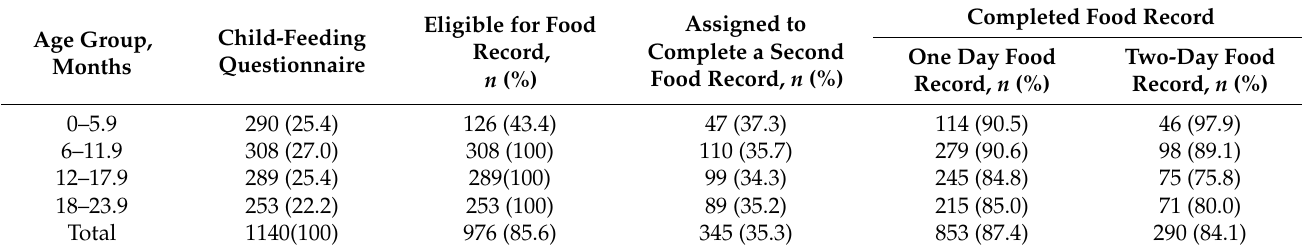
Table 1. Completed questionnaire, food record, and follow up interview by age band for infants and toddlers enrolled in OzFITS 2021 ( n = 1140).